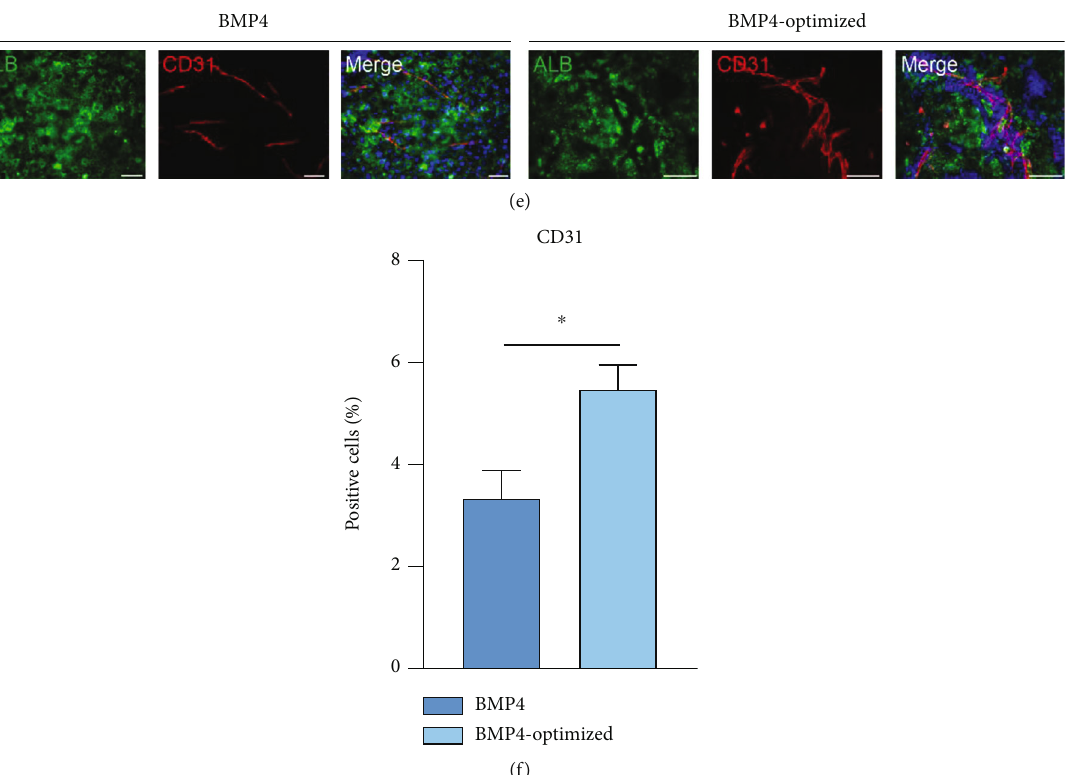
Figure 4: Optimization of the BMP4 di ff erentiation protocol signi fi cantly promotes nonparenchymal cell production. (a) Schematic representation of the hepatocyte di ff erentiation procedure during day 0 to day 30. The bright fi eld images showed the sequential morphological changes (days 0-30) of hiPSC di ff erentiation into hepatocytes. Scale bars, 50 μ m. (b) Quantitative PCR analysis showed the expression levels of endothelial lineage markers. ∗ p < 0 : 05 , ∗∗ p < 0 : 01 , ∗∗∗ p < 0 : 001 , and n = 3 . Immuno fl uorescence showed